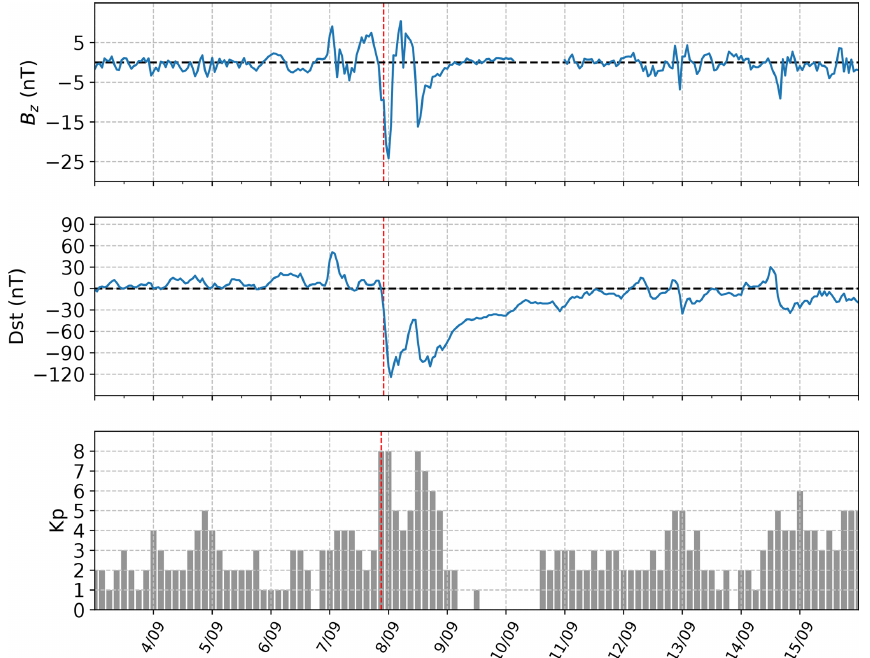
Figure 1. The vertical component of the interplanetary magnetic field ( B z ) and the Dst and Kp indices between 3 and 16 September 2017. The vertical dashed red line in all the plots points to the storm sudden